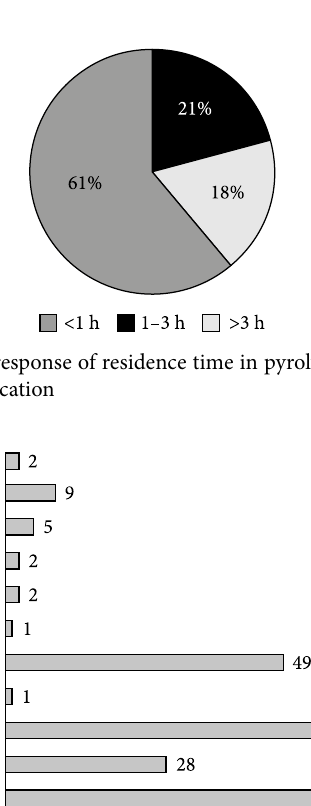
Fig. 4. Survey response of pyrolysis temperature (n = 328)